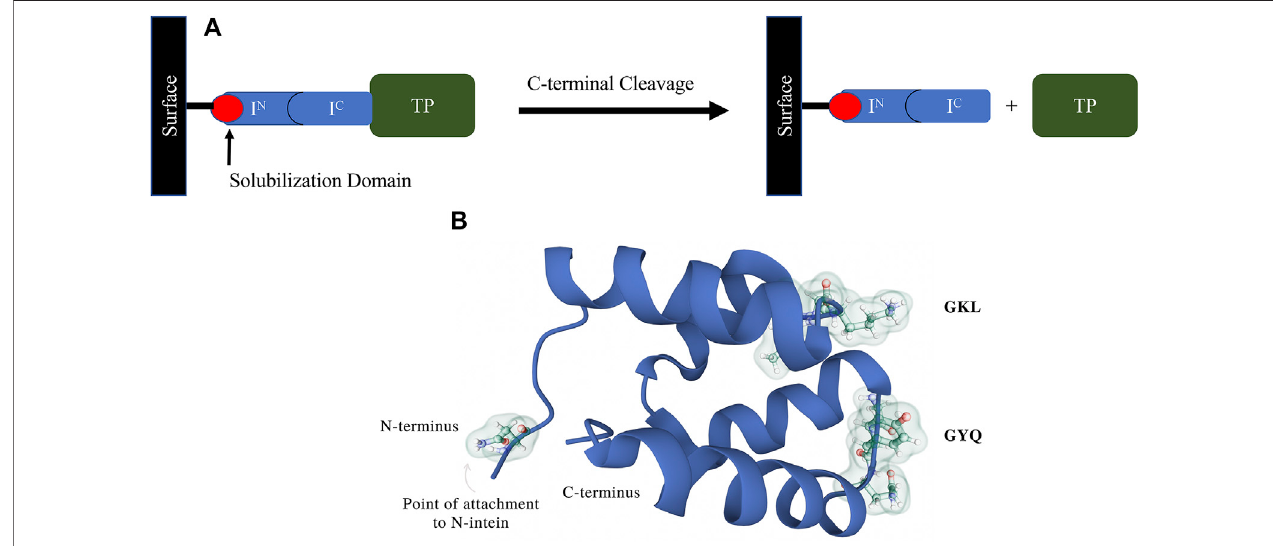
FIGURE 8 | (A) . This fi gure from a patent fi led by scientists at Merck KGaA (Zillmann and Orlando, 2019; Patent No.: US 10308679 B2; prioritized in 2014, fi led in 2015 and approved in 2019) presents aschematic diagram depicting an af fi nity puri fi cation methodbased on a self-cleaving tag,as well asasolubilization domain used for manufacturing the split intein ligand. The method employs an af fi nity chromatography matrix listed in the invention comprising a fusion protein having an N-intein polypeptidefusedtoanN-inteinsolubilizationpartnerthatisattachedtoasolidsupport.AsecondfusionproteincomprisingaC-inteinthatiscomplementarytothe N-intein on the af fi nity matrix is fused to the target protein to be puri fi ed (POI) alongside any other elements required for expression, such as secretion signals. (B) . The structure of solubilization partner 138 (p138, PDB ID 1RYK) is also shown (Yee et al., 2002). The protein contains four alpha helix domains, is globular and has a long unstructured coil that forms the connection to the carboxy terminus of the N-intein. The loop regions GKL and GYQ were targeted for cysteine residue insertions away from the catalytic site to create the new versions of p138 that would be functionalized for single-point resin attachment via thiol-coupling